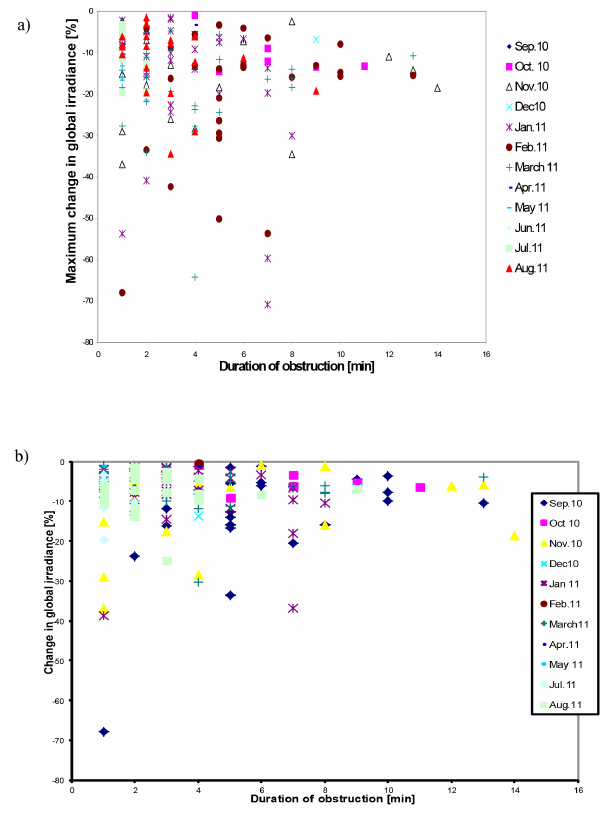
Figure 4. The maximum (a) and mean (b) reduction in global irra- diance (during the shading event) as a function of the duration of the shading event by the contrails is shown for the 12 months that were analysed. For June 2011 no shading event was suited for the analysis because of interfering cloudiness which falsified the global irradiance decrease.